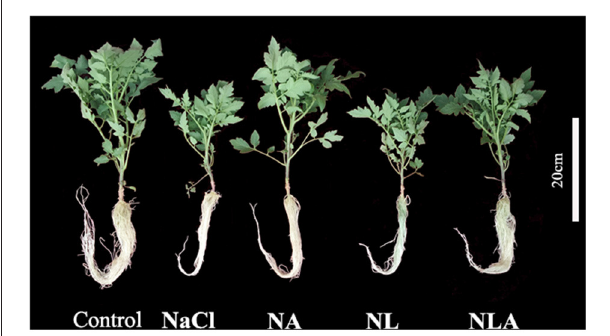
FIGURE 1 | Growth of salt-stressed tomato seedlings with or without exogenous ascorbic acid (AsA) and lycorine (LYC) spraying. Control, no added NaCl, no sprayed AsA and LYC; NaCl, added 100 mmol/L NaCl; NA, added 100 mmol/L NaCl and sprayed 0.5 mmol/L AsA; NL, added 100 mmol/L NaCl and sprayed 0.25 mmol/L LYC; NLA, added 100 mmol/L NaCl and sprayed 0.25 mmol/L LYC and 0.5 mmol/L